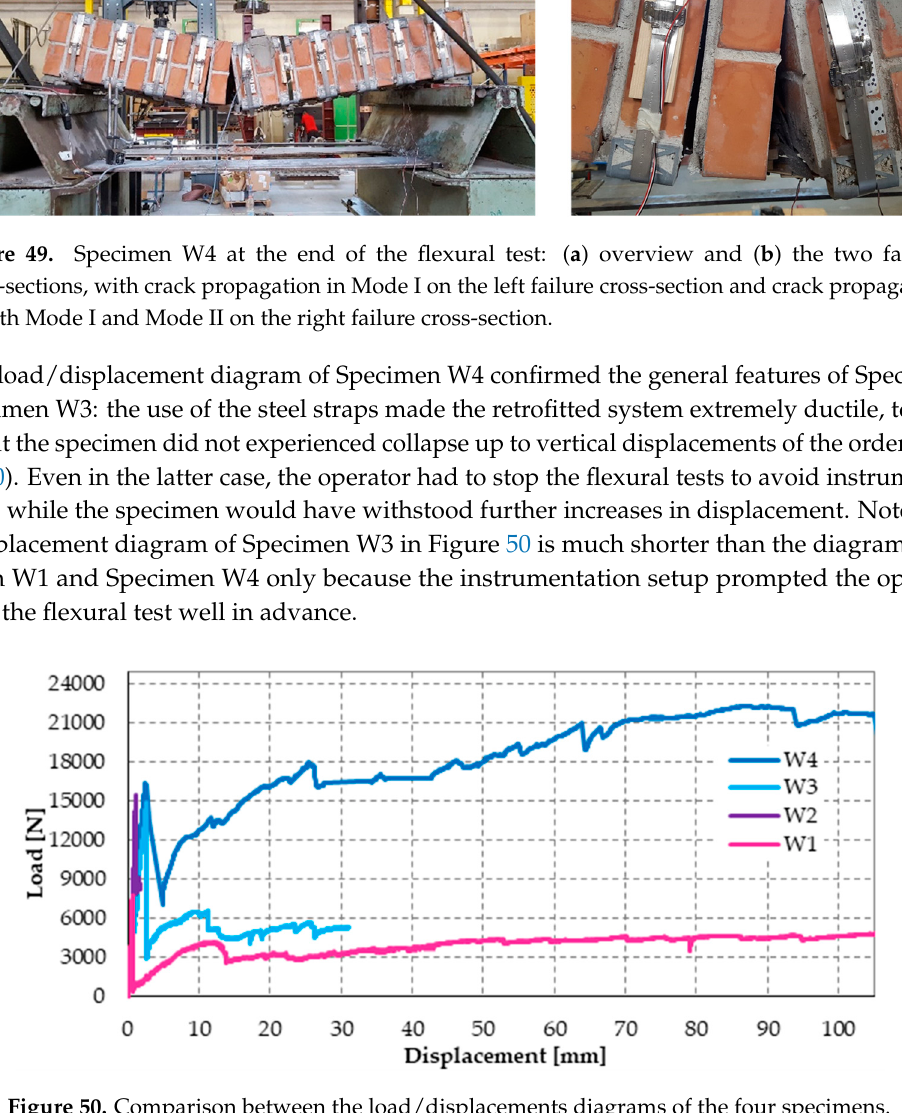
Figure 50. Comparison between the load/displacements diagrams of the four specimens.